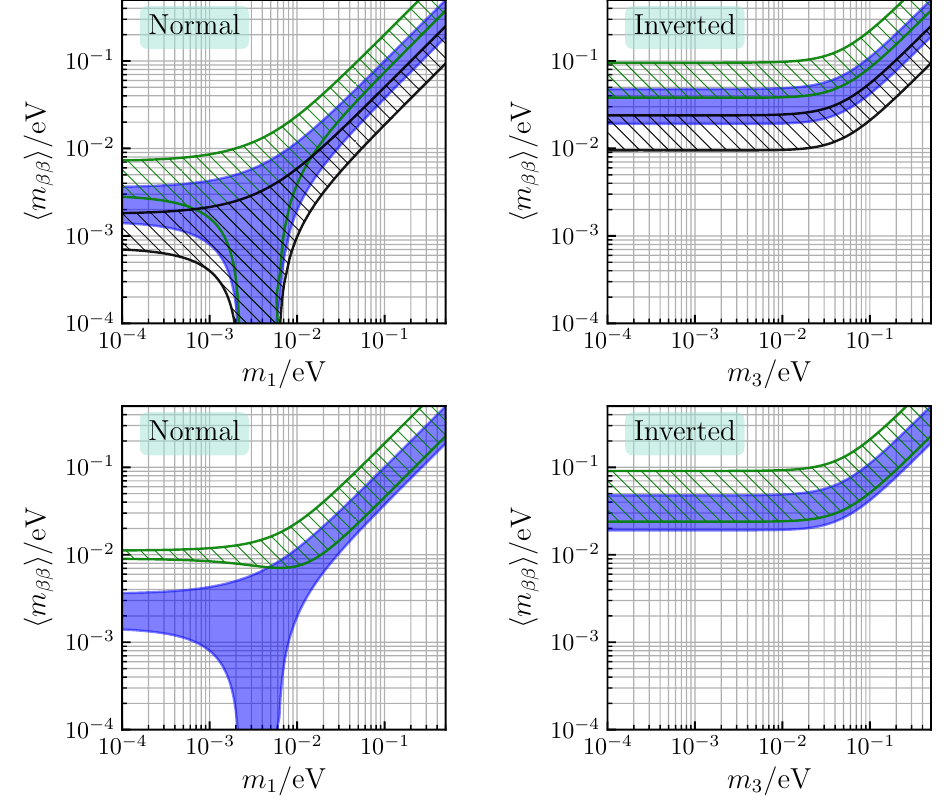
Figure 3 . Loop-modi(cid:12)ed 0 (cid:23)(cid:12)(cid:12) decay. The blue regions are the standard predictions of h m (cid:12)(cid:12) i constructed from current best-(cid:12)t values of oscillation parameters and arbitrary Majorana phases. The upper plots assume a common suppression (black hatched) or enhancement (green hatched) of the e(cid:11)ective mass by a factor of 2. The lower plots assume that (cid:3) 2 contributions from (cid:3) 1 and (cid:3) 3 , see eq. (3.3). The left and right plots are for the normal and inverted mass ordering,